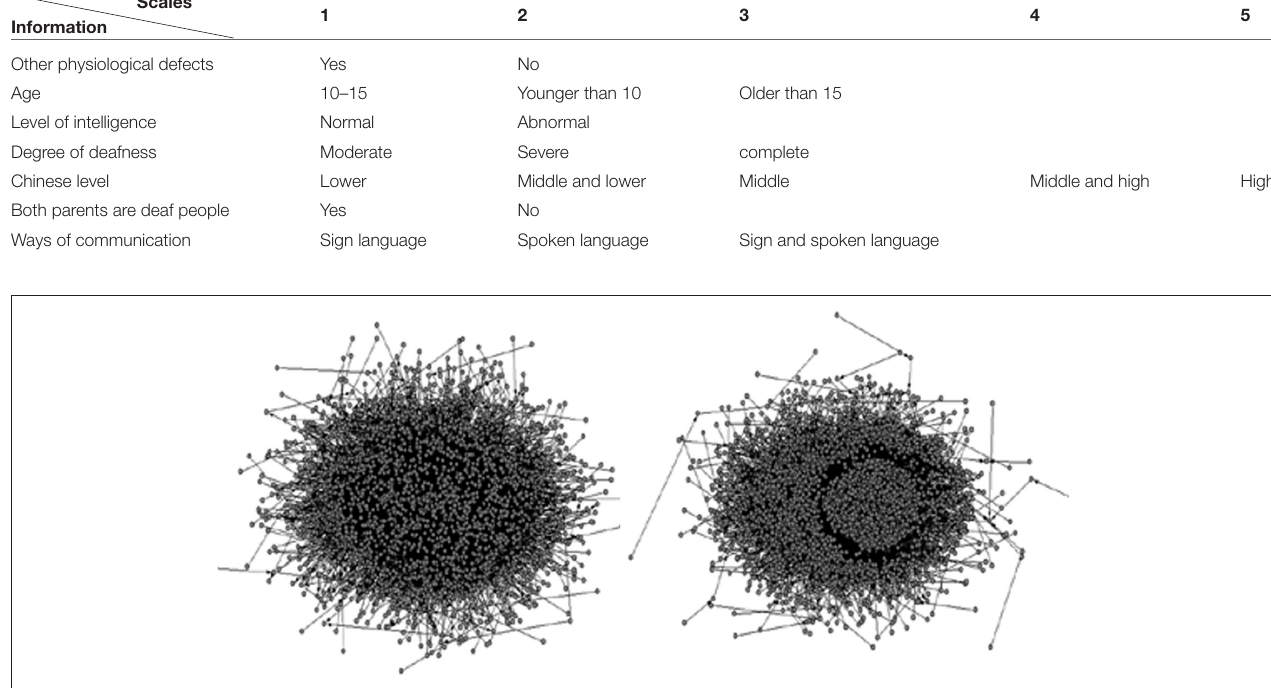
FIGURE 4 | The syntactic dependency network structures of DHHs Chinese writing (on the left) and their NHs Chinese writing (on the